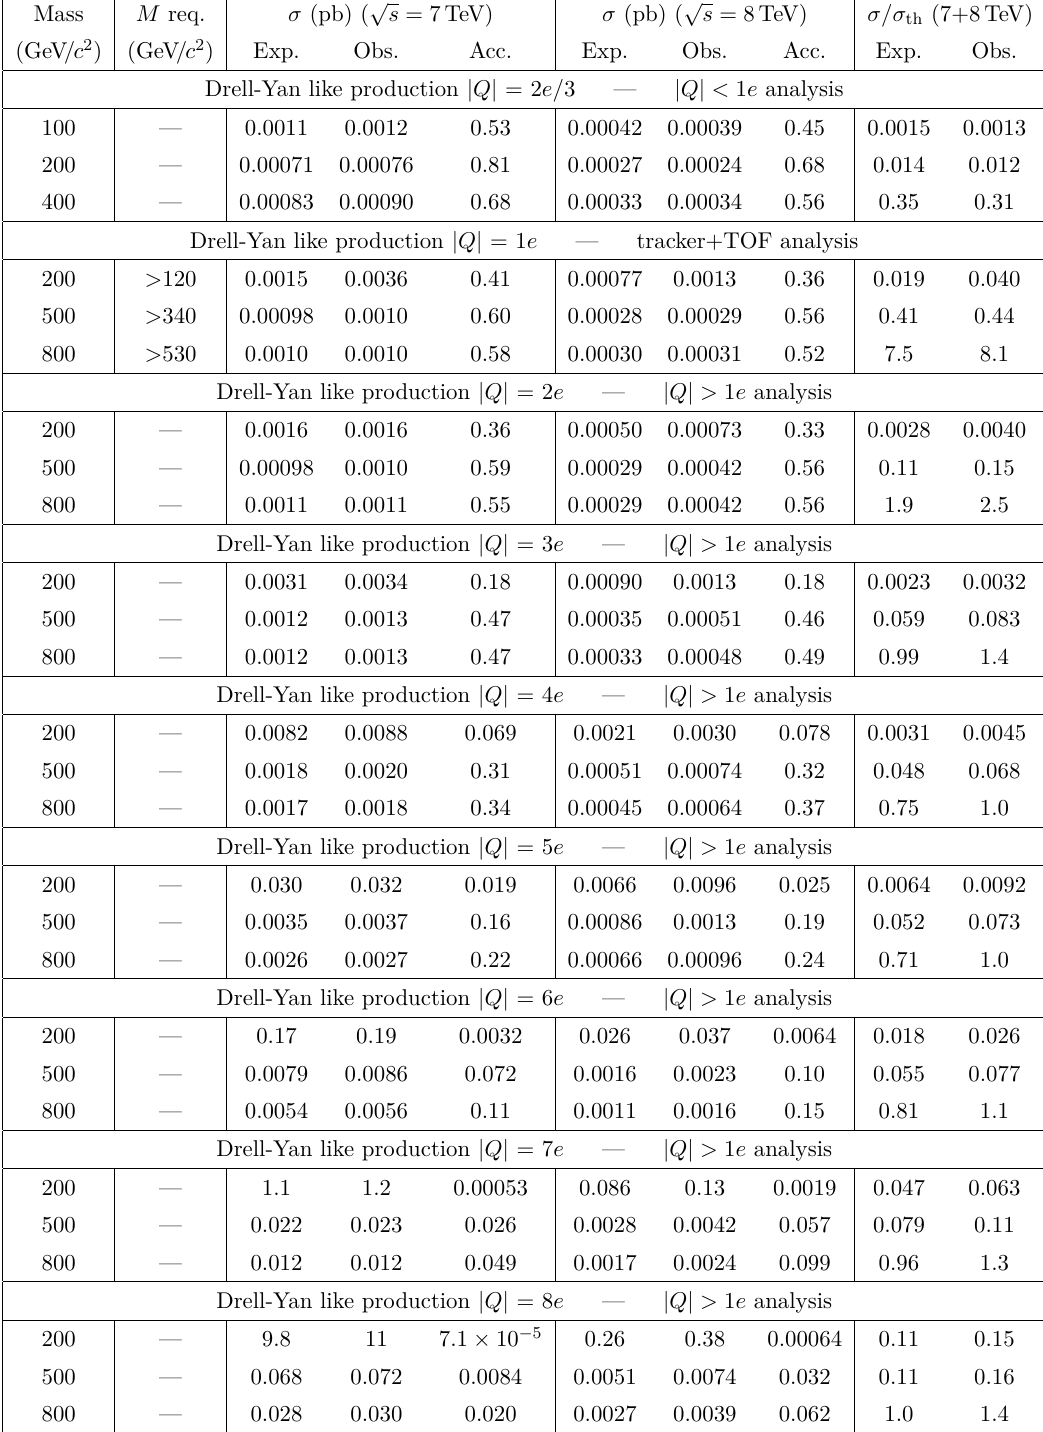
Table 8 . Expected and observed cross section limits and the signal acceptance for the Drell-Yan like production of fractionally, singly, and multiply charged particles at the ratio of the cross section limit to the theoretical value for the combined dataset. The minimum reconstructed mass required ( M req.) for each sample in the tracker+TOF analysis is also